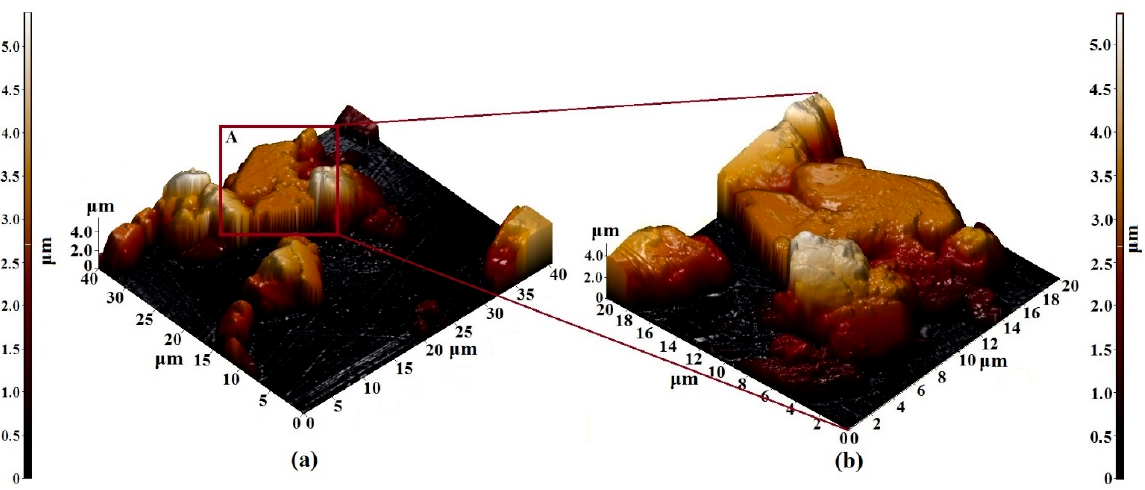
Figure 8. AFM 3D—image of the surface topology of ( a ) 40 × 40 μ m 2 and ( b ) 20 × 20 μ m 2 sections of the Er 3 Fe 5 O 12 film formed on the Al 2 O 3 substrate.